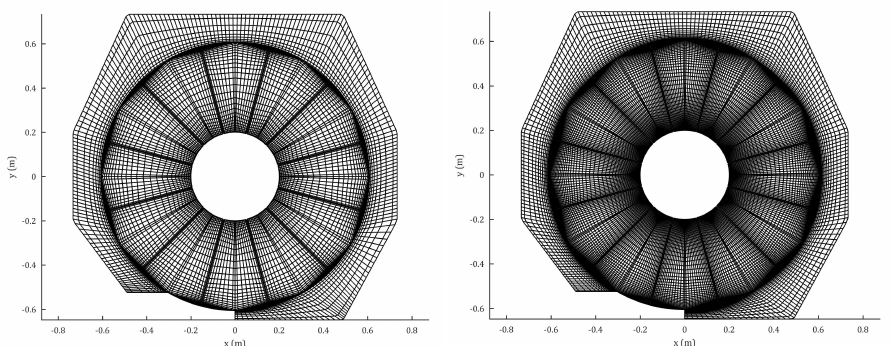
Figure 9. Part of the computational mesh around the HPM, for the coarse ( left ) and fine ( right )